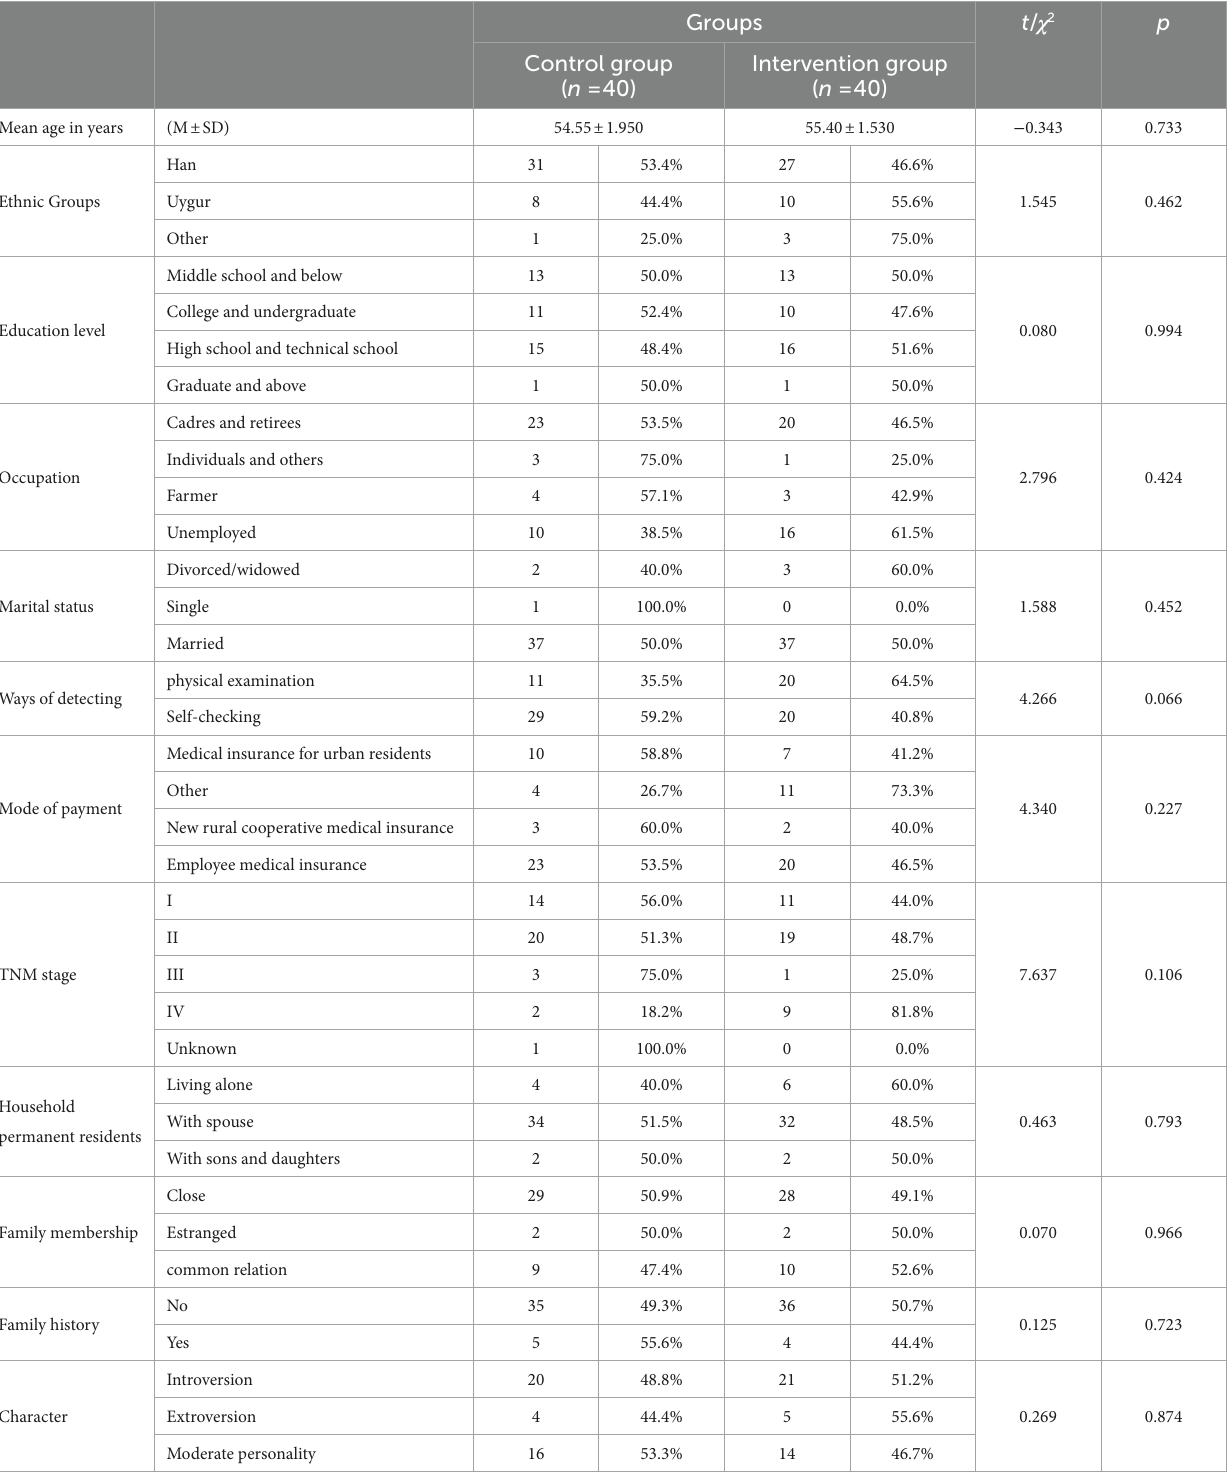
TABLE 1 General information of patients with breast cancer ( n = 80).